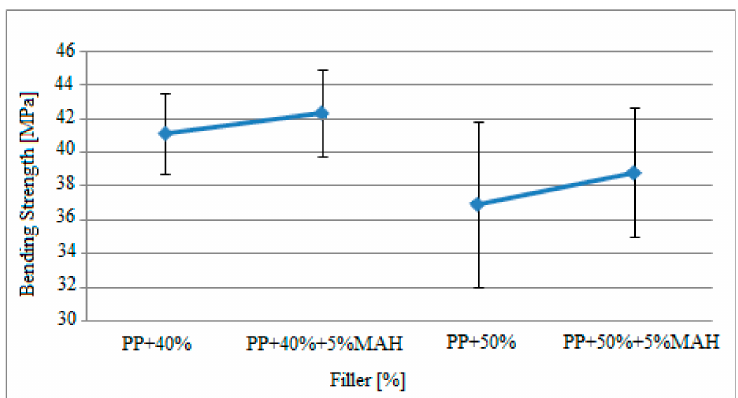
Figure 8. The bending strength findings for filler material reinforced polypropylene containing 5% MAH and exposed to gamma radiation.